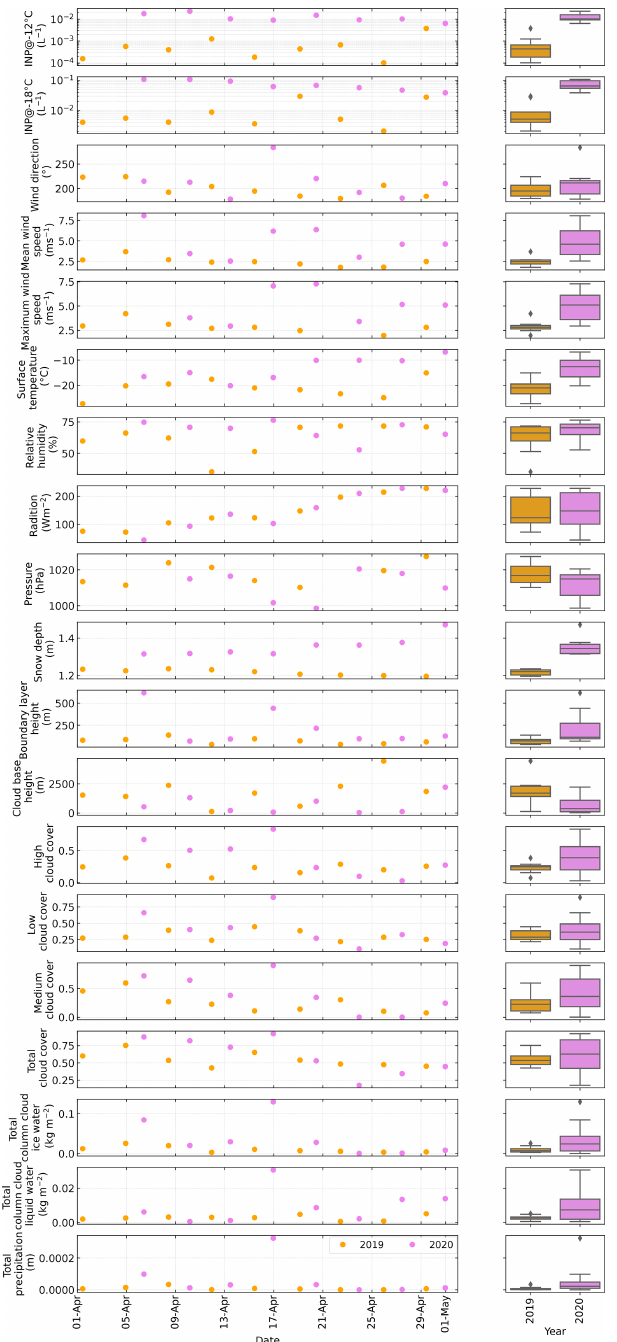
Figure 11. Filter-wise average of investigated meteorological pa- rameters as well as the INP concentration at − 12 ◦ C and − 18 ◦ C in April 2019 (orange) and 2020 (purple) are shown in time series (left). Corresponding box plots of all data points in the April of the respective year are shown on the right hand panel.